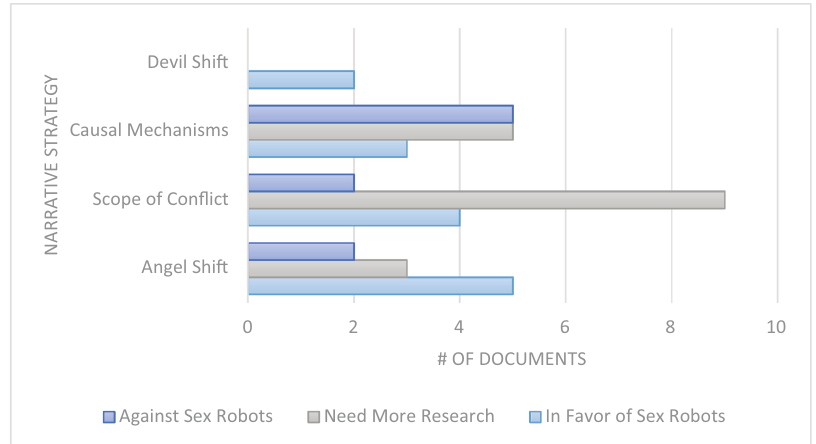
Figure 10: Sex robot - coded narrative strategies by coalition ( Scopus )